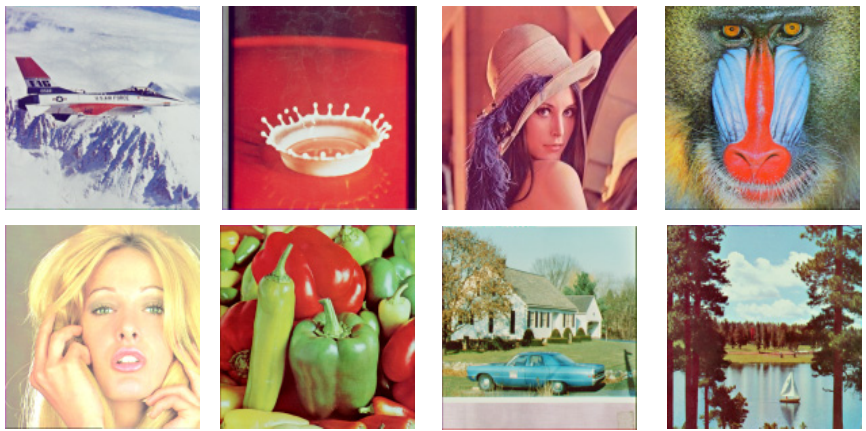
Figure 11. Eight images used for the PSNR comparison in Table 3. Table 4. PSNR (dB) comparison of previous DCT algorithms and this work using the second im- age dataset shown in Figure